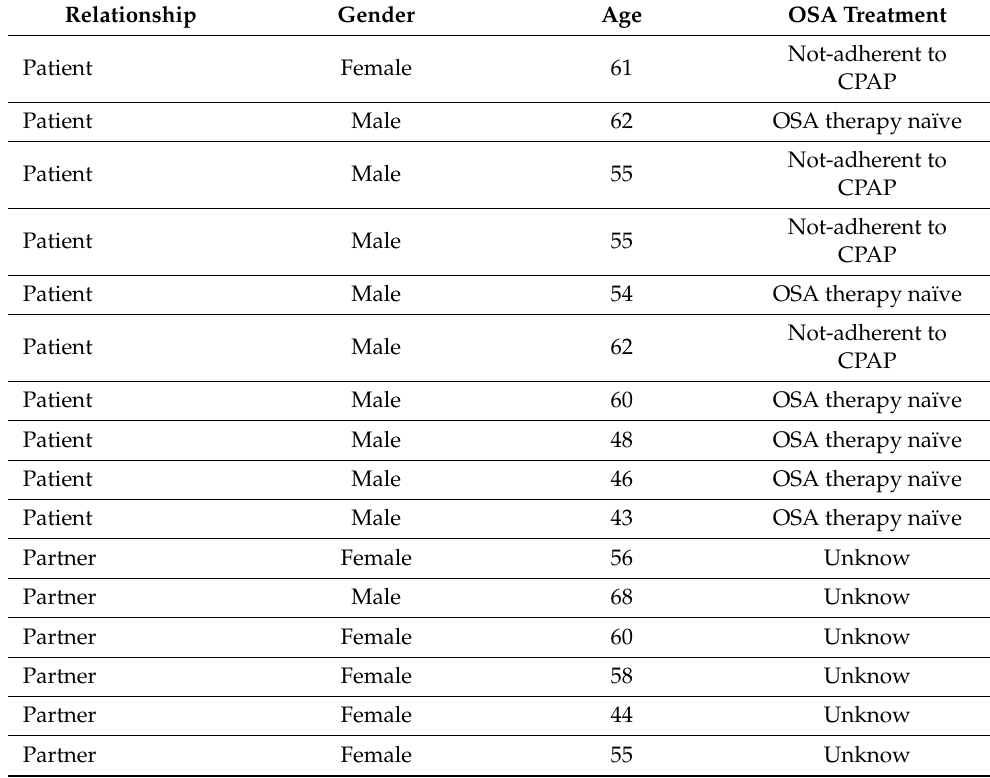
Table 2. Patient/partner